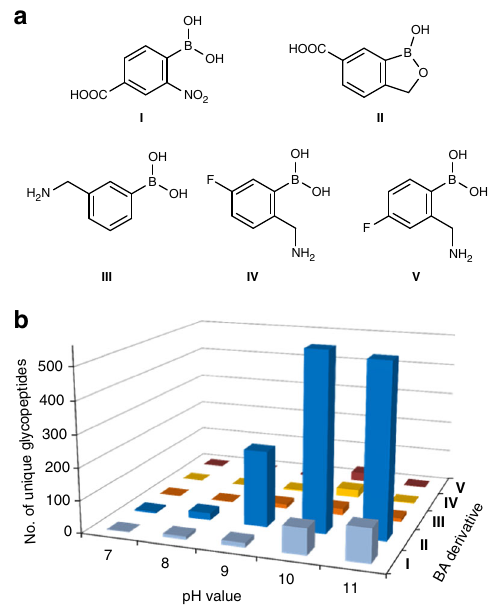
Fig. 1 Structures of boronic acid derivatives and experimental results using different derivatives. a Structures of boronic acid derivatives tested in this work. b The number of unique N -glycopeptides identi fi ed with each BA derivative at varying pH values from the parallel